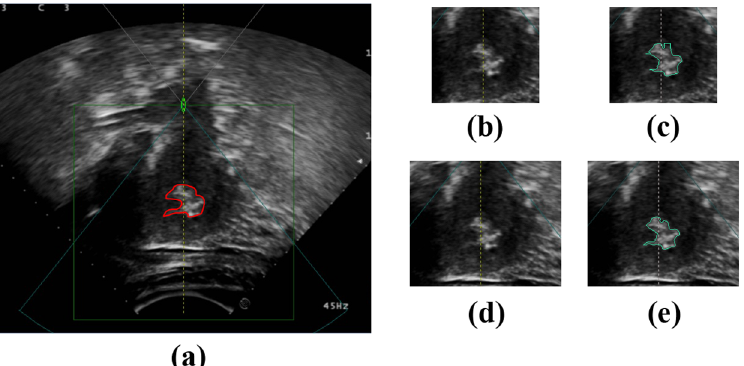
Fig 15. An example of tumor segmentation with hyper-echoic appearance in different ROIs. (a) The original image. (b) The first ROI image. (c) Segmentation result of (b). (d) The second ROI image. (e) Segmentation result of